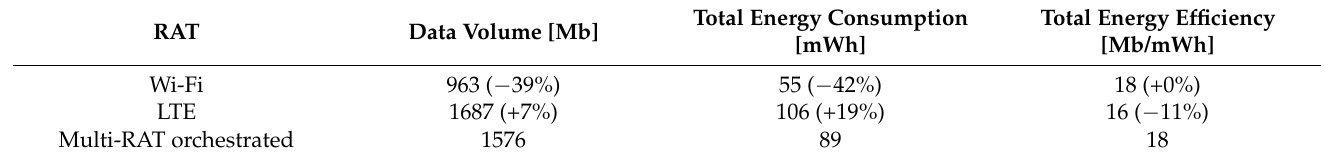
Table 5. Summary of aggregated KPIs for two different scenarios with indication of relative gains for Scenario